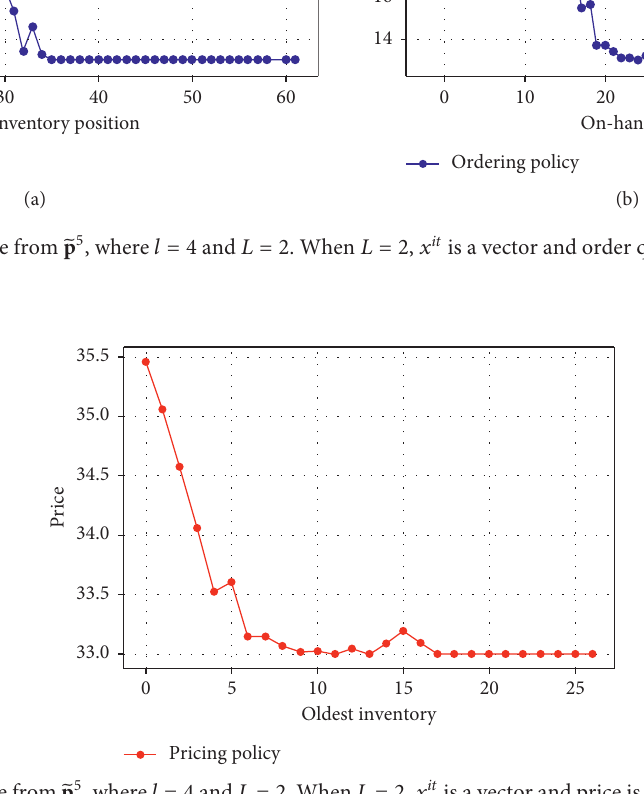
Figure 8: This statistic results are from 􏽥 p 5 , where l � 4 and L � 2. When L � 2, x it is a vector and price is the mean from the same inventory